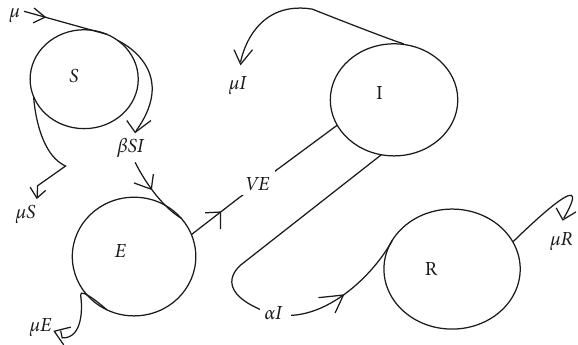
Figure 1: Flowchart of the whooping cough